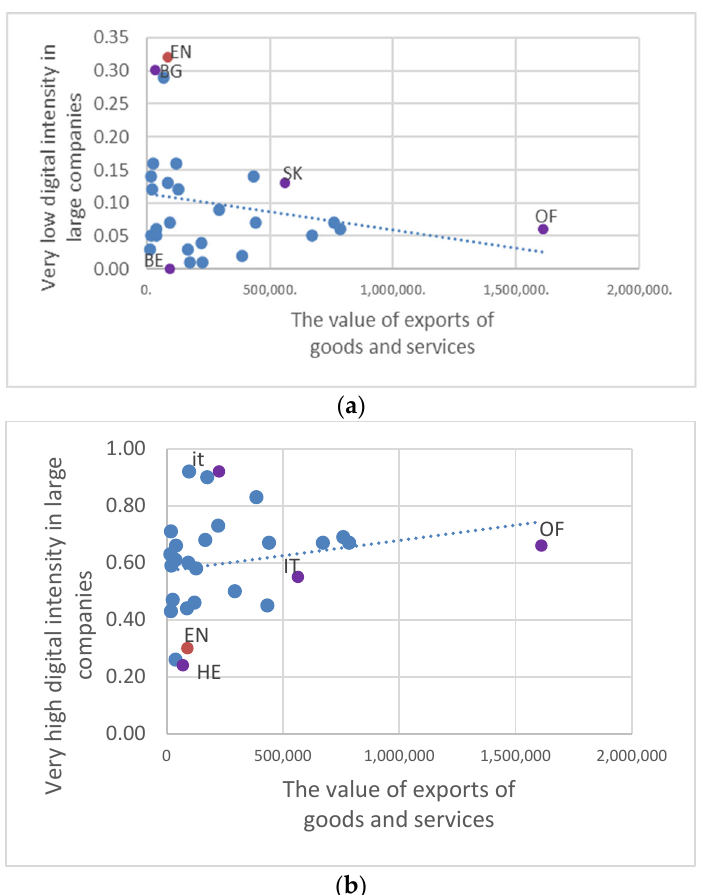
Figure 8. The relationship between digital intensity for SMEs and EU exports in 2019. ( a ) The value of exports of goods and services for very low digital intensity in SMEs. ( b ) The value of exports of goods and services for very high digital intensity in SMEs.